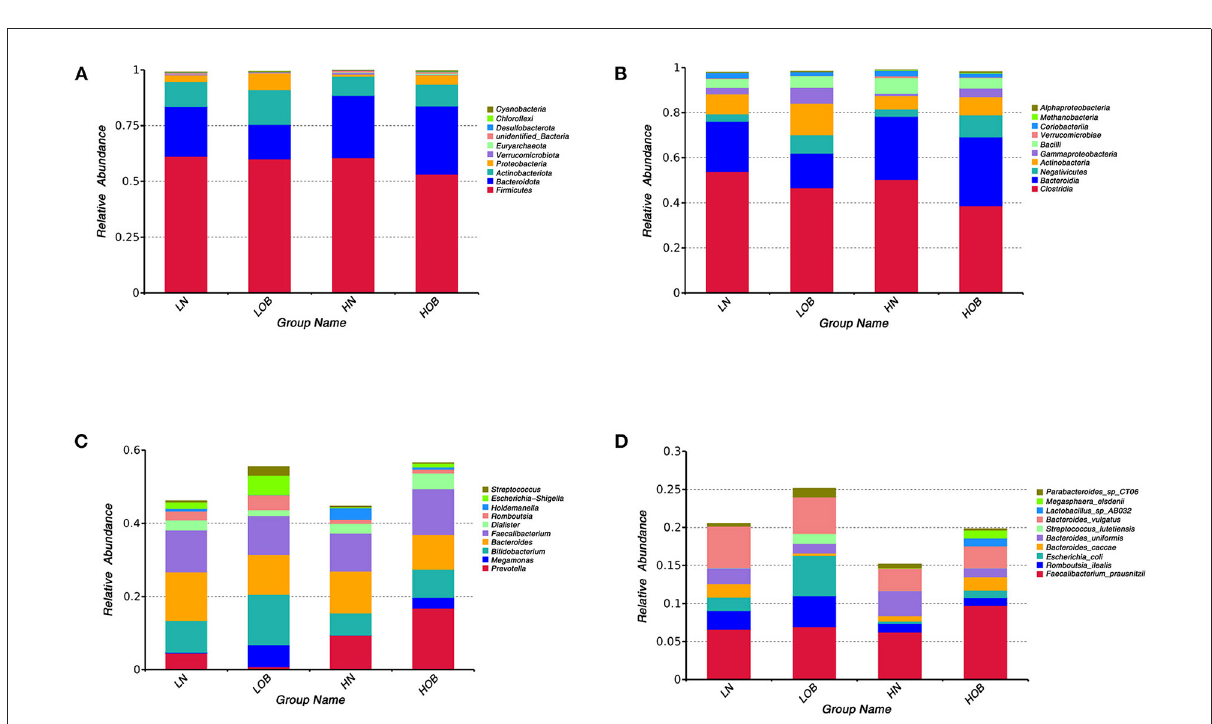
FIGURE3 Community composition of fecal microbiota in four groups. In the bar chart, each bar represents the average relative abundance of each bacterial taxon. The taxa with high relative abundances at the phylum level (top 10, A ), class level (top 10, B ), genus level (top 10, C ) and species level (top 10, D ) are shown. LN, low-altitude obese children; LOB, low-altitude obese children; HN, high-altitude normal weight children; HOB, high-altitude obese